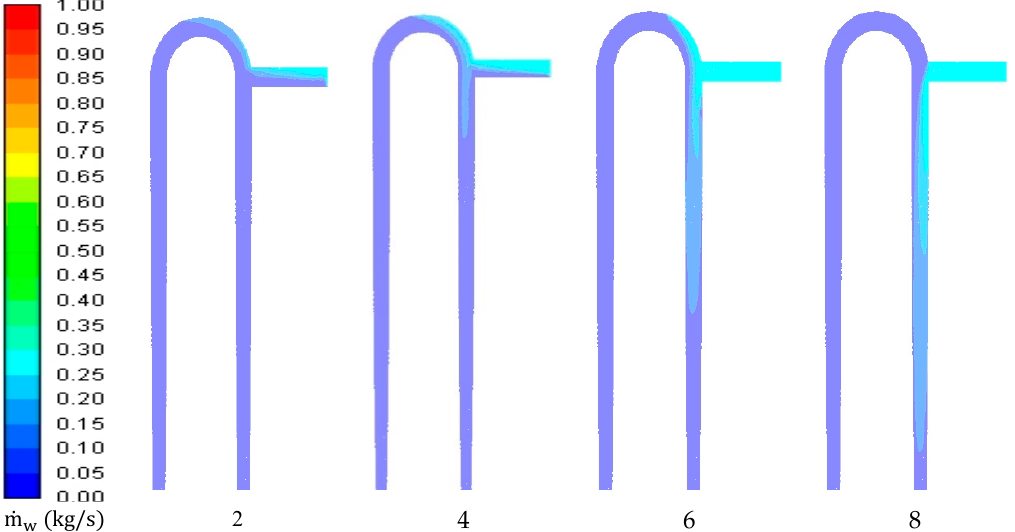
Figure 20. Vapor volume fraction contours at di ff erent flow ratios and X w = 462.42, α m = 0.7 and X v = 0.1 .